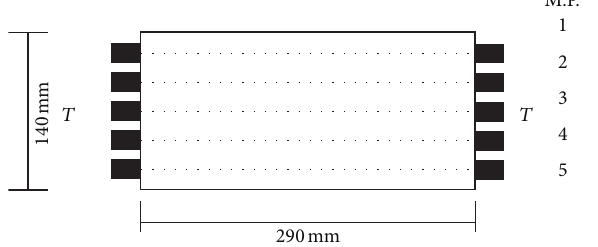
Figure 1: Scheme of direct sound transmission CSB.